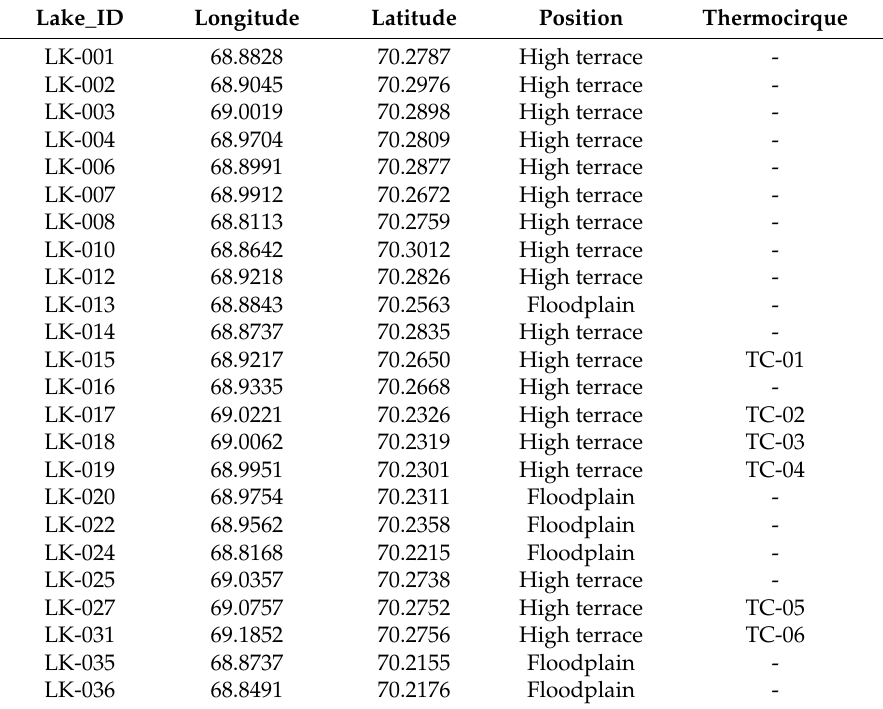
Table 1. Central Yamal lakes from which the samples were taken for colored dissolved organic matter (CDOM). Lake_ID Longitude Latitude